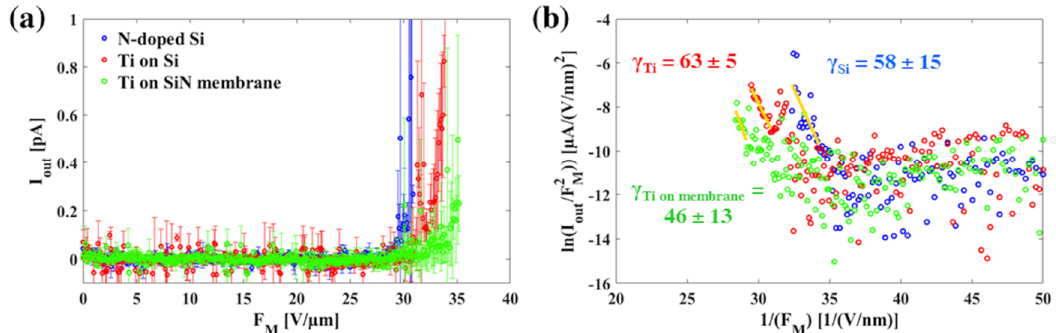
Figure 11. ( a ) For each sample type, the mean of two subsequent measurements of the output current (I out ) in dependence on the macroscopic electric field (F M ) is shown, with the standard deviation as an error bar. Offset and slope—caused by the transimpedance amplifier and the ohmic resistance of the plate-capacitor like measurement assembly, respectively—have already been subtracted from the data. ( b ) FN theory was used to derive γ from the linearized experimental data [45] and the errors were calculated from the standard deviations of the linear fits.